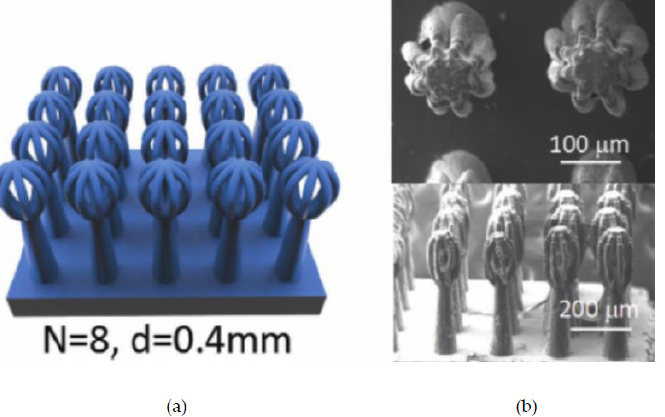
Figure 42 . An example of a hydrophilic “egg-beater” microstructure printed using a DLP-based printing method, showing ( a ) the CAD model, and ( b ) an electron microscope image of the printed part, where the scale bar is 100 μ m ( top ) and 200 μ m ( bottom ). (Reprinted from [166], with the permission of John Wiley & Sons Inc.).